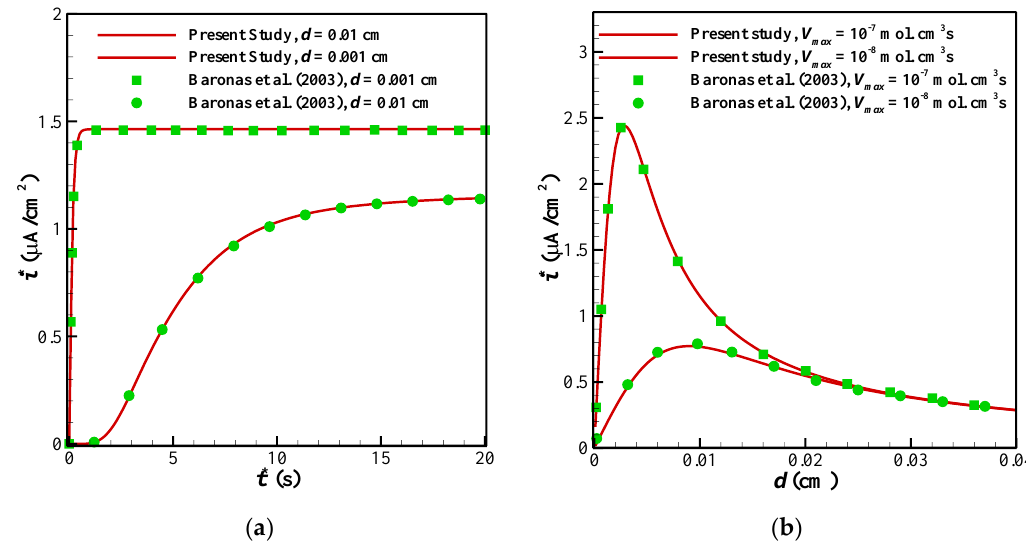
Figure 3. Comparison between the results of the present study with [10]: ( a ) variation in the dynamic current of the biosensor with the time and thickness of the enzyme membrane ( d ) for V max = 10 −7 mol/cm 3 s; ( b ) dependency of the maximal current of the biosensor on the maximal enzymatic rate ( V max ) and the thickness of the enzyme membrane.